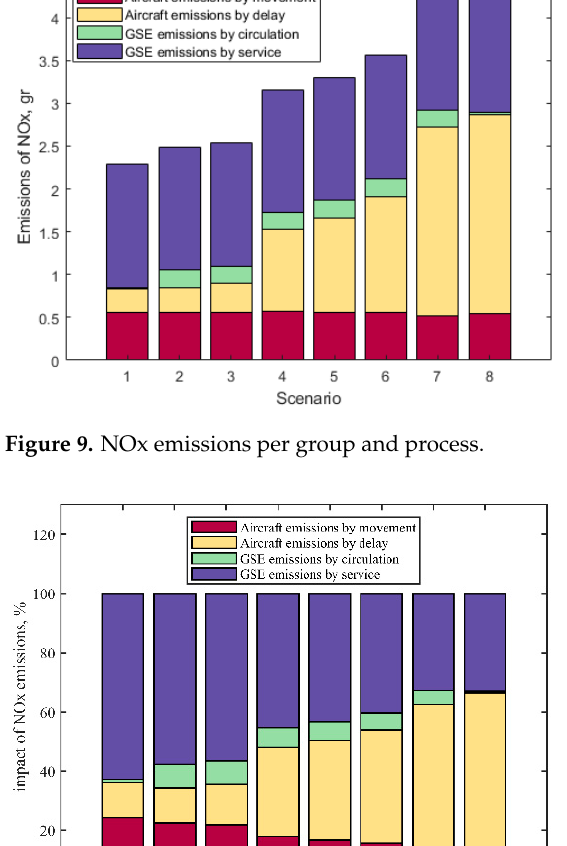
( b ) Figure 12. GSE emissions for different configurations and types of aircraft operations, ( a ) CO, ( b ) NOx. On the other hand, each scenario and, as a consequence, each stand assignment pol- icy brings forth a different requirement of vehicles and, therefore, of kilometers covered per vehicle. Table A6 shows that the number of vehicles varies in the scenario under anal- ysis. However, it does not present a behavior proportional to the variables used in the characterization of the demand (%Aes y %Se). Furthermore, excluding the GSE associated with passenger transport, the number of vehicles required shows a stable performance with a variation range around its average value of +/ − 1 vehicle (approx. +/ − 10%). In such cases, it is noted that, given the number of travelling GSE, the inclusion of a new vehicle does not imply a significant increase in the required total (see Table 6).